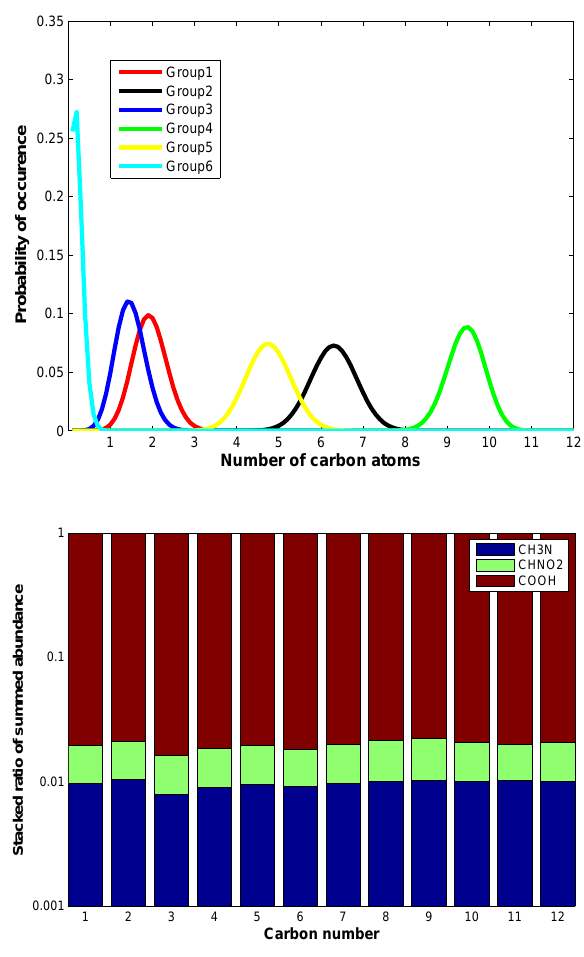
Fig. 1. (a) An illustration of a randomly-generated distribution Fig. 1. a) An illustration of a randomly-generated distribution of of functional groups as a function of the carbon number. In each functional groups as a function of the carbon number. In each case, distributions of the 29 functional groups represented within case, distributions of the 29 functional groups represented within the modified-UNIFAC model are generated (38 including hydrocar- the modified-UNIFAC model are generated (38 including hydrocar- bon groups); only 6 are shown here for clarity; b) the fractional bon groups); only 6 are shown here for clarity; (b) the fractional distribution of three examplary functional groups across all 1000 distribution of three examplary functional groups across all 1000 initialisations, showing that the COOH group is present at roughly initialisations, showing that the COOH group is present at roughly 100 times the mixing ratio of the CH 3 N and CHNO 2 groups figure 100 times the mixing ratio of the CH 3 N and CHNO 2